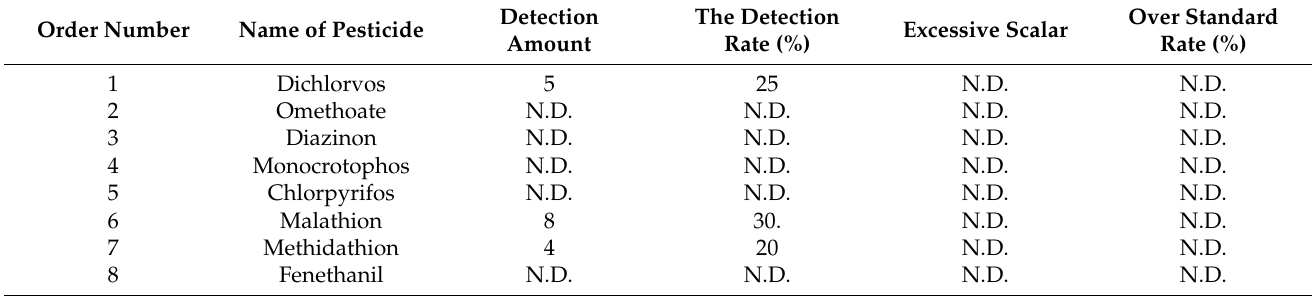
Table 3. Detection results of pesticides residue in cabbage.